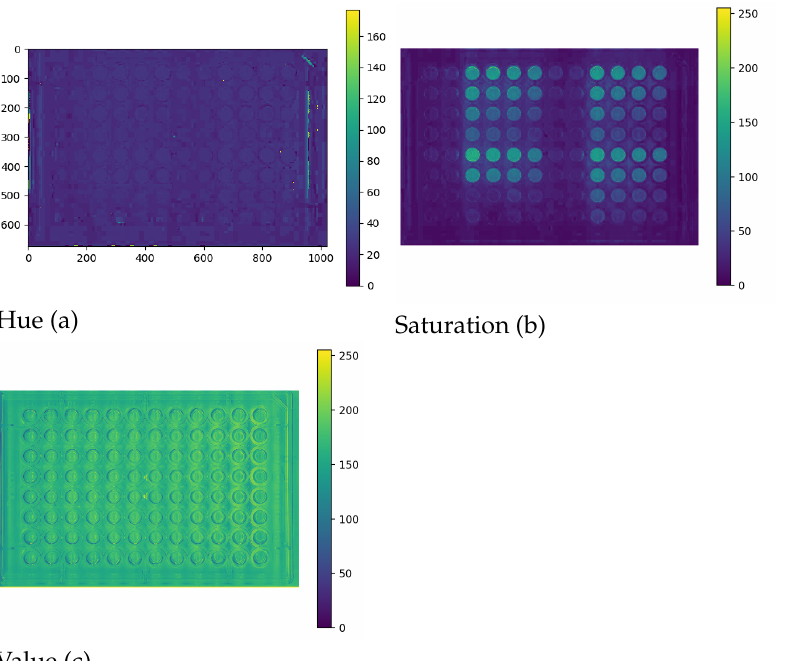
Figure 3. HSV transformation of the ELISA image of Figure 2, showing ( a ) only the hue, ( b ) only the saturation, and ( c ) only the value.